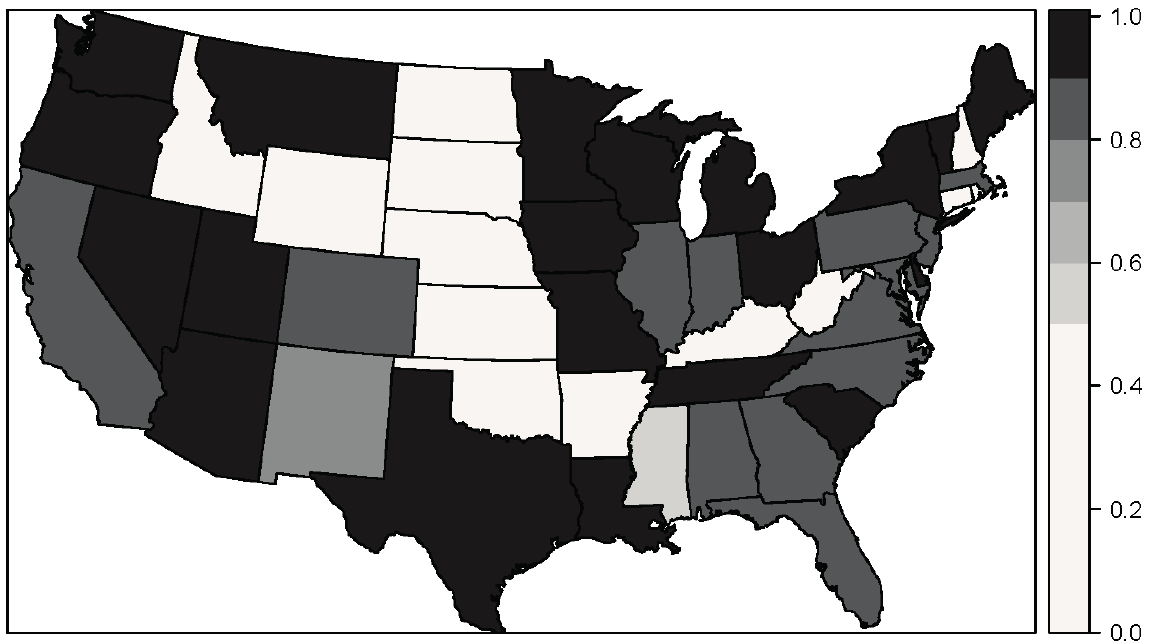
Figure 3. Detailed street match rate (Metric 3) by state using the enhanced LexisNexis